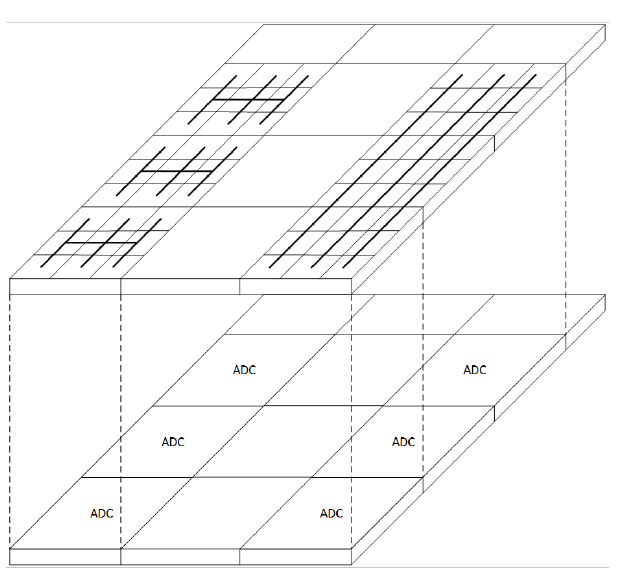
Figure 1. High level concept of a 3D-stacked core CIS implementation.